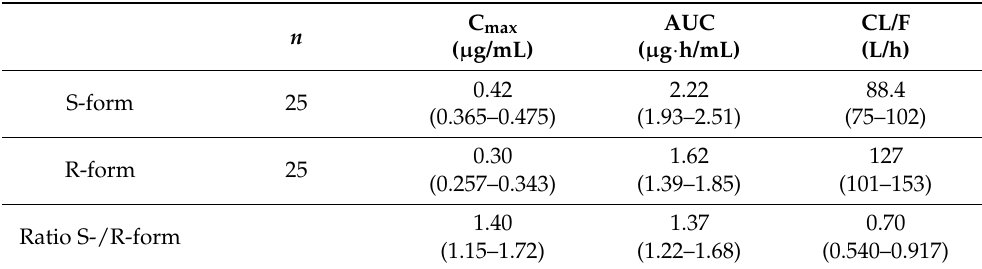
Table 4. Pooled analysis of propafenone pharmacokinetics stratified by PPF enantiomers at a dose of 400